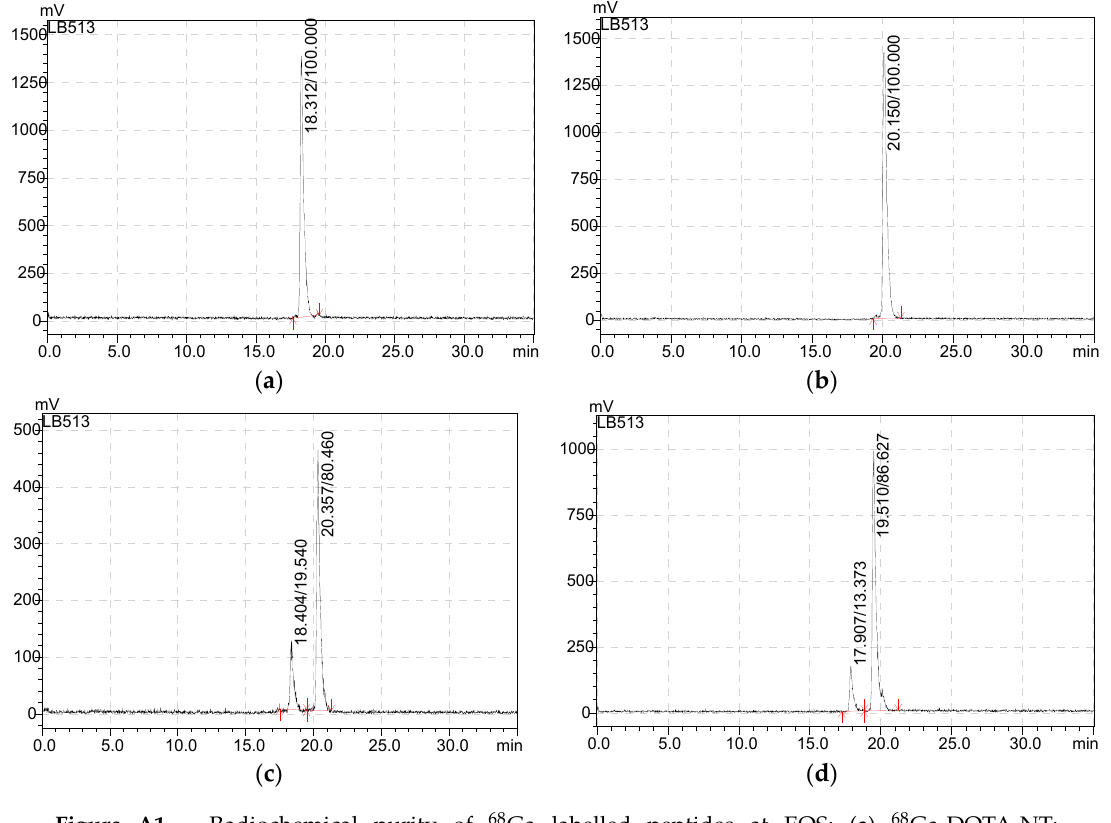
Figure A1. Radiochemical purity of 68 Ga labelled peptides at EOS: ( a ) 68 Ga ‐ DOTA ‐ NT; ( b ) 68 Ga ‐ DOTA ‐ MN; ( c ) 68 Ga ‐ DOTA ‐ PEG(4) ‐ BBN(7 ‐ 14); ( d ) 68 Ga ‐ DOTA ‐ NMB.